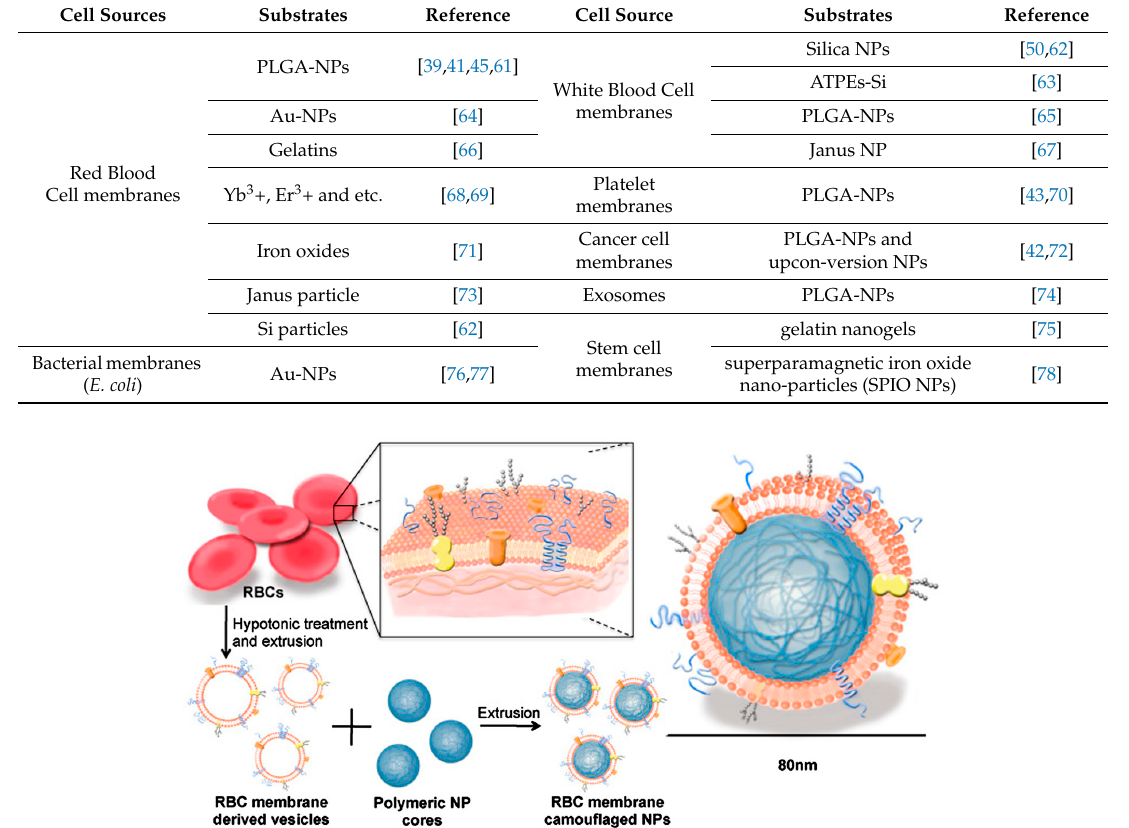
Table 1. A summary of the current uses of cell membranes.